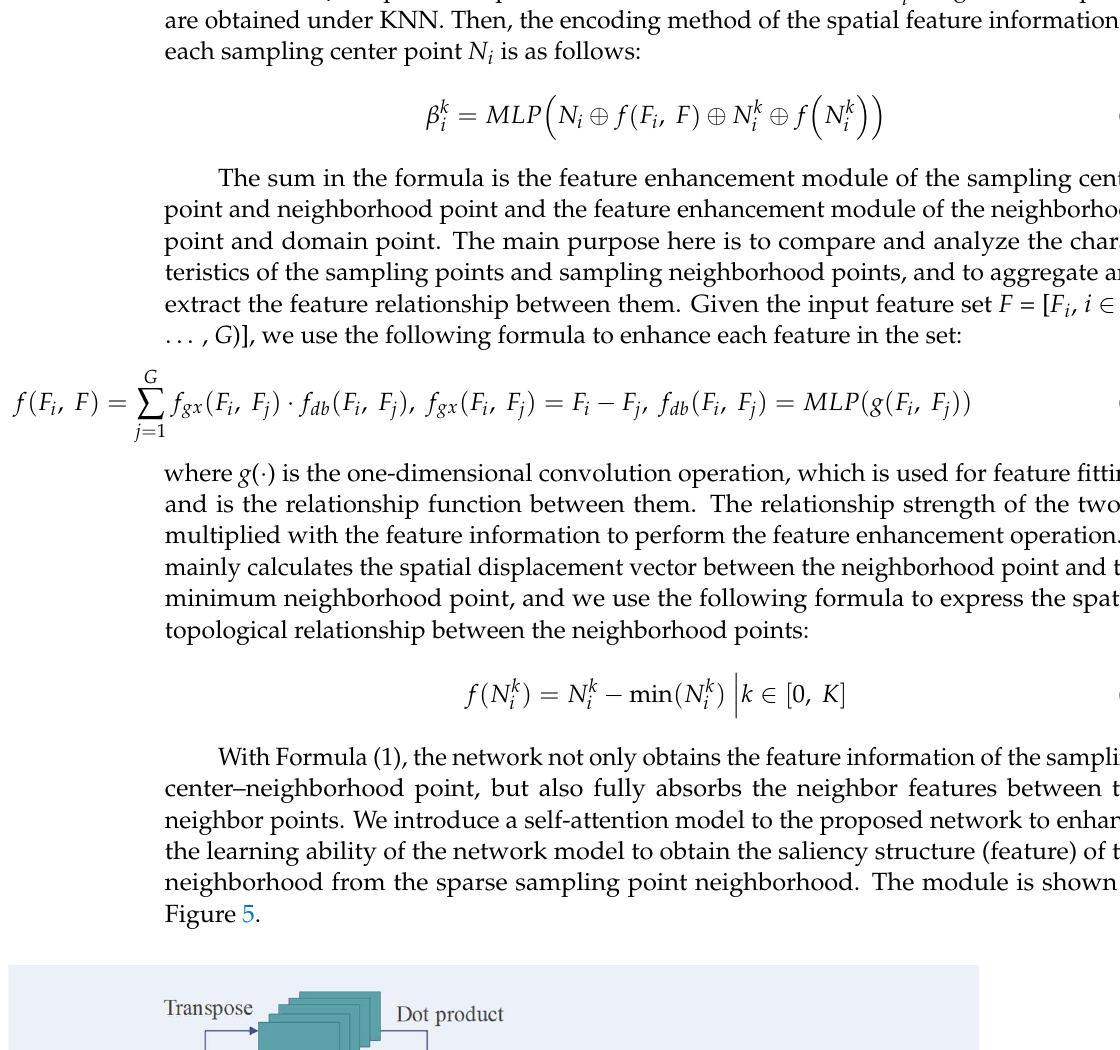
Figure 4. SC feature learning module for the downsampling layer.